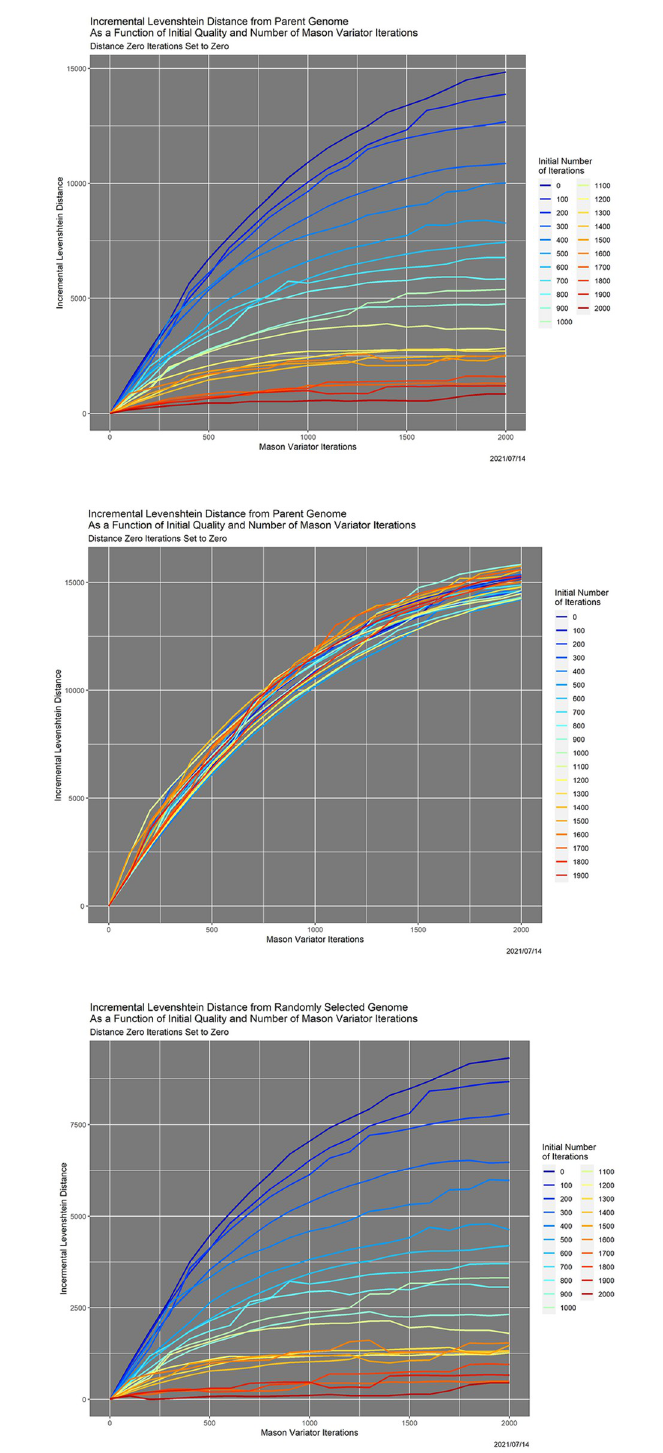
Fig 2. Degradation behavior as a function of Mason_variator iterations and initial data quality, for a randomly selected coronavirus genome. A: Degradation is measured by incremental Levenshtein distance from the parent (0-iteration) genome. B: Degradation is measured by Levenshtein distance from the starting point. C: Degradation is measured by incremental Levenshtein distance from a second randomly selected genome in the NCBI database. Color encodes the initial number of Mason_variator